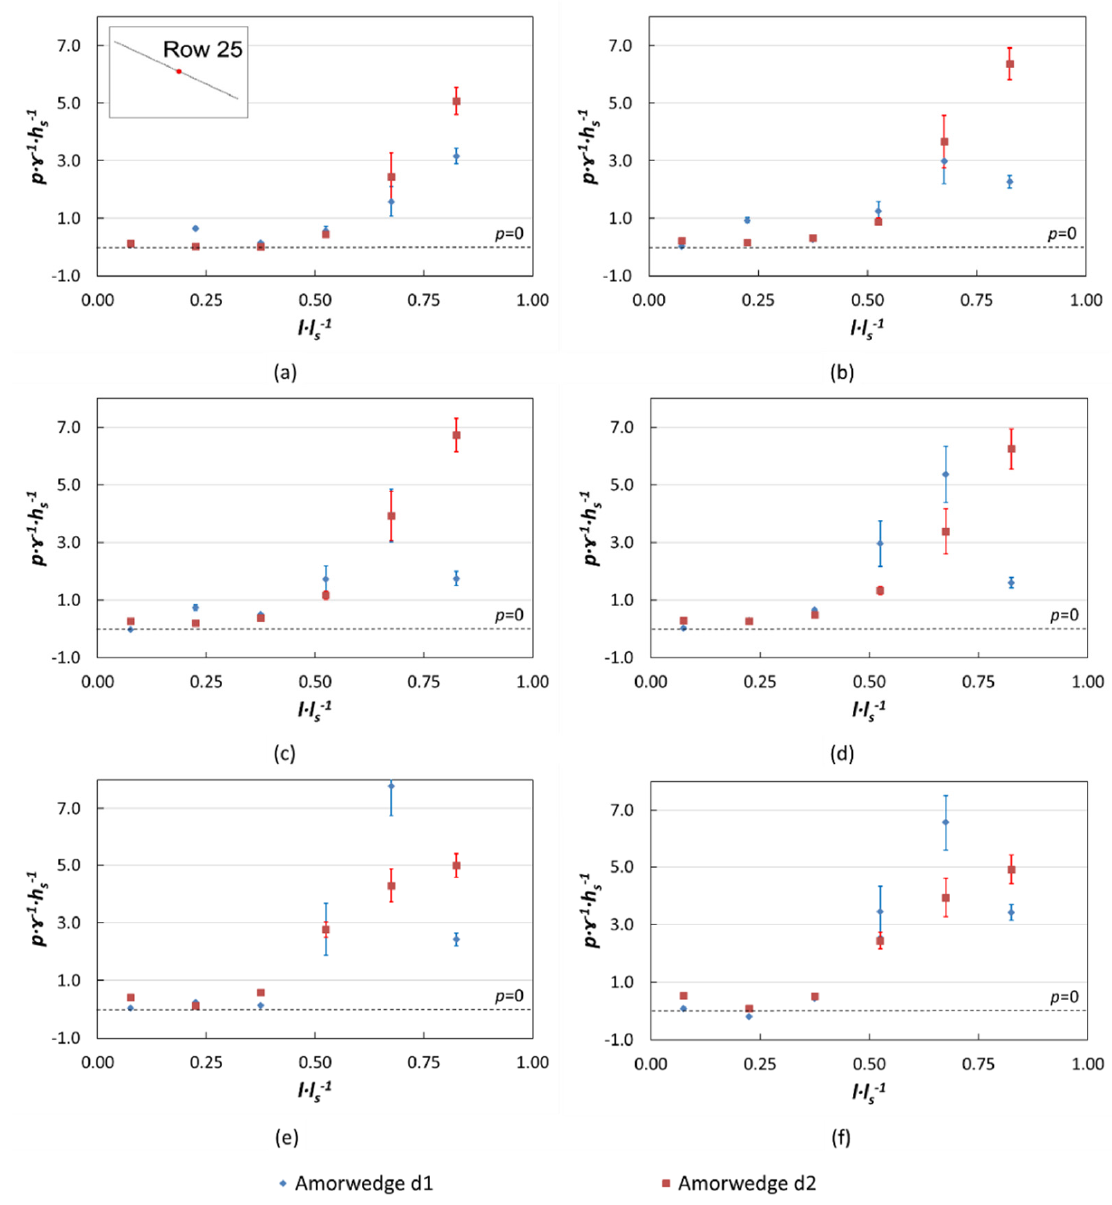
Figure 12. Average and standard deviation of the hydrodynamic pressures registered on the tread of Armorwedge TM block ( w 1) in row 25 of the chute in different drainage conditions: free drainage, d1 , and gravel drainage layer, d2 , with unit